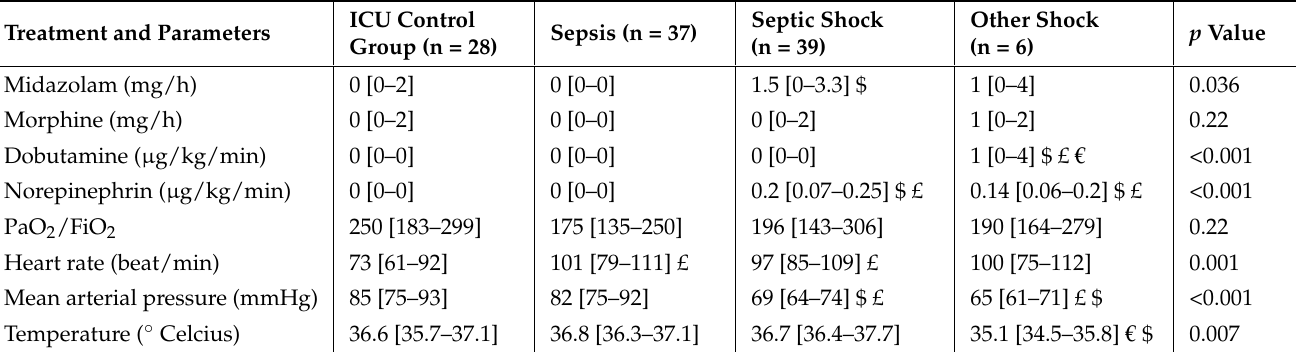
Table 4. Treatment and hemodynamic variables in the different patient